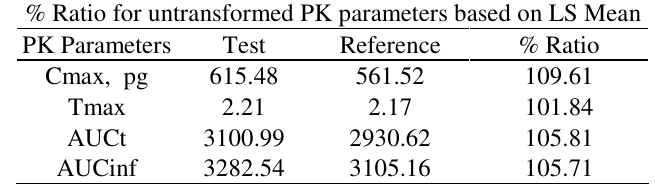
Figure 3. Mean concentration versus time profile Table 4. Pharmacokinetic parameter